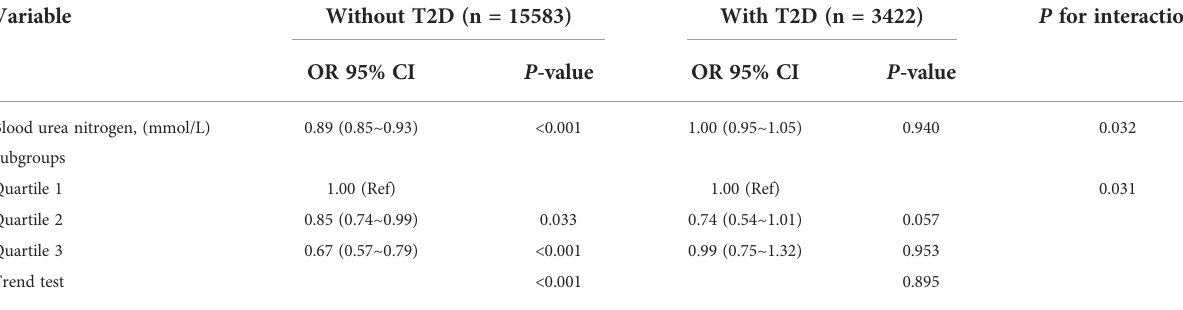
TABLE 4 Interactive effect of blood urea nitrogen and depression in patients with and without T2D (All participants). Variable